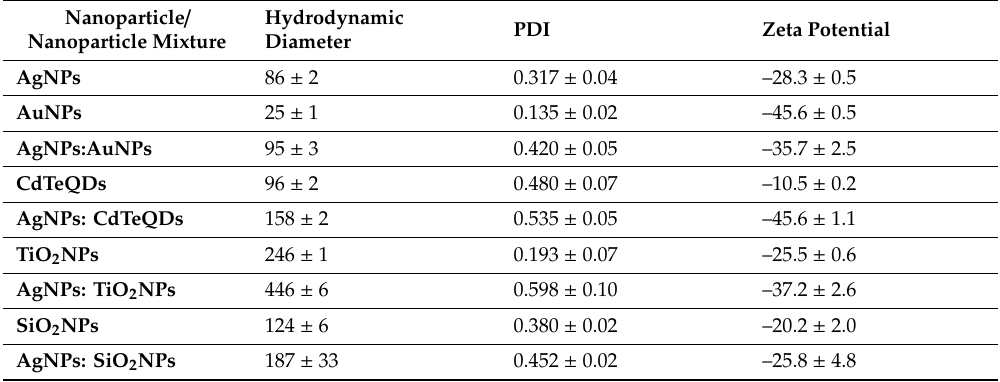
Table 1. Hydrodynamic diameter and zeta potential of nanoparticles (NPs) alone or their mixtures.